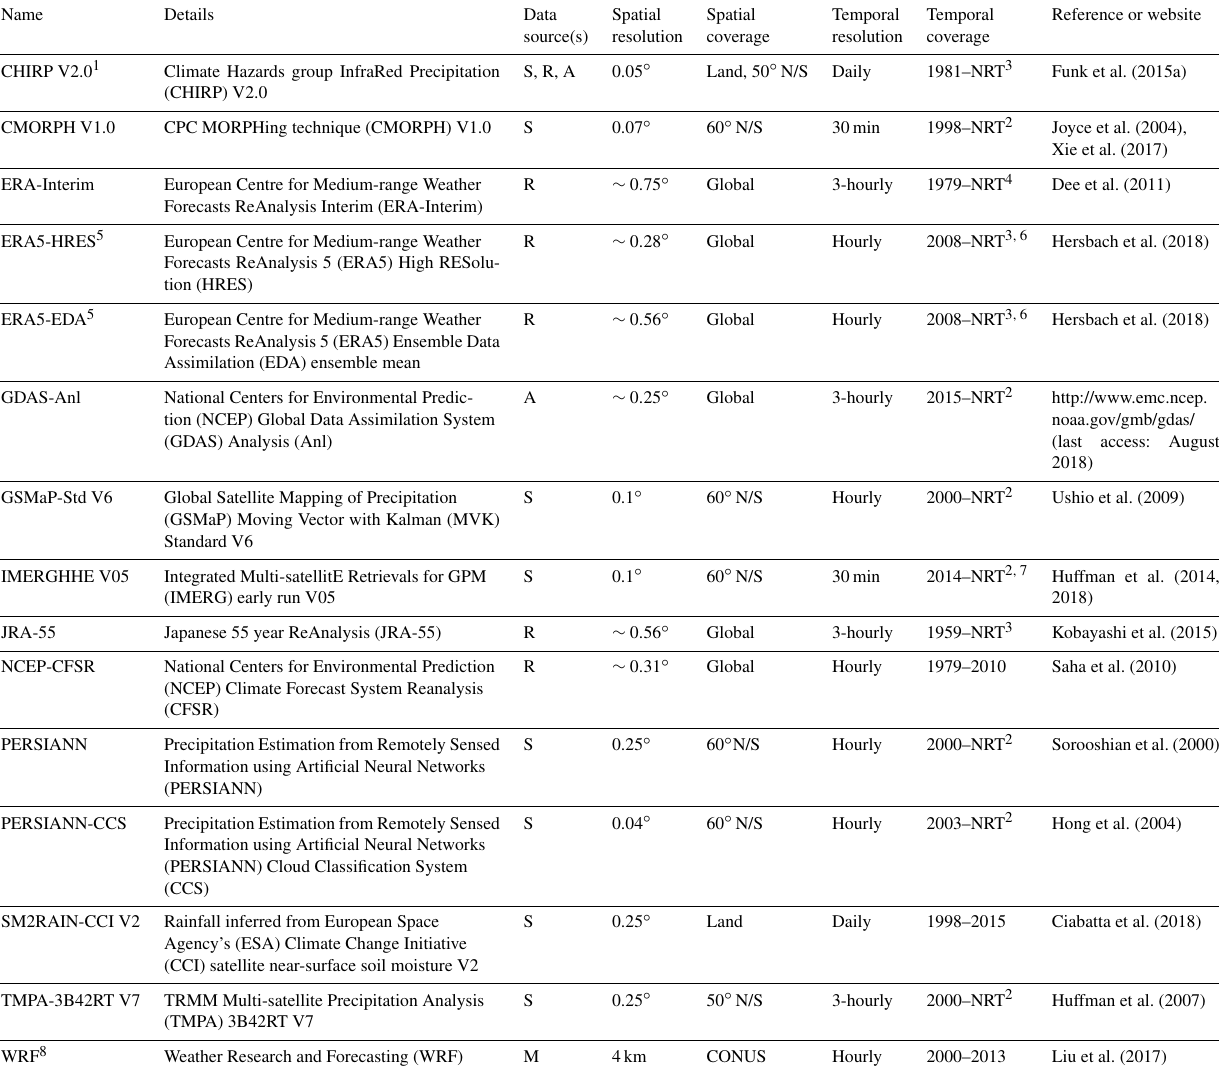
Table 1. Overview of the 15 uncorrected (quasi-)global (sub-)daily gridded P datasets evaluated in this study. The 11 gauge-corrected datasets are listed in Table 2. Abbreviations in the data source(s) column defined as S, satellite; R, reanalysis; A, analysis; and M, regional climate model. The abbreviation NRT in the temporal coverage column stands for near real time. In the spatial coverage column, “Global” means fully global coverage including oceans, while “Land” means that the coverage is limited to the terrestrial land